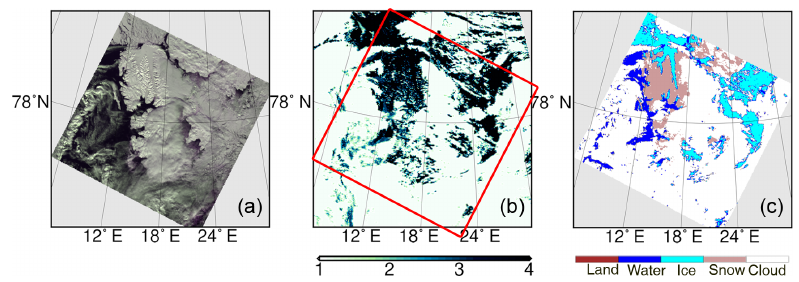
Figure 13. (a) The RGB false-colour image (using 0.67, 0.87 and 0.55µm channels) of SLSTR over Svalbard, 18 April 2017, 10h 15min 6s, (b) MODIS cloud mask: 1 is cloudy, 2 is probably cloudy, 3 is probably clear, 4 is clear (red rectangle shows the coverage of AATSR) for 11h 30min, (c) cloud detection of ASCIA.